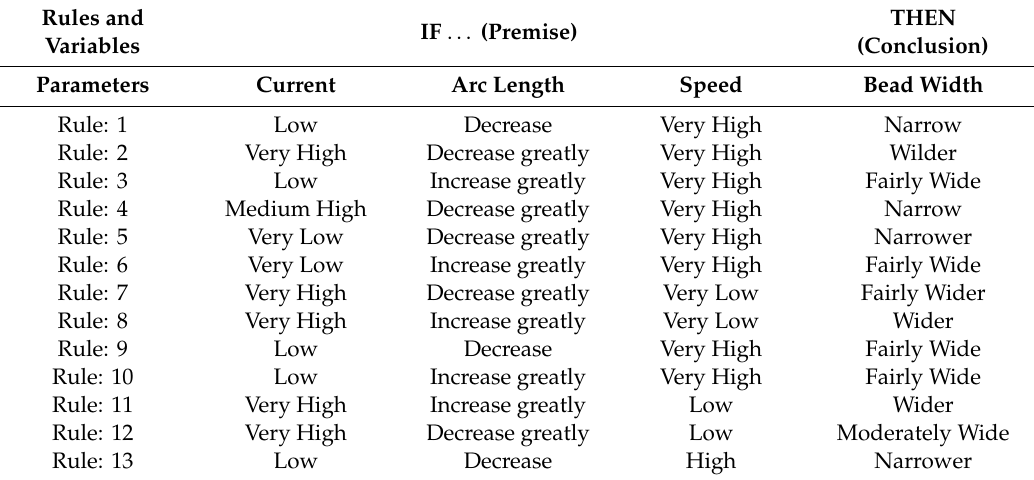
Table 2. Linguistic rules used in designing the fuzzy logic-based Likert algorithm.